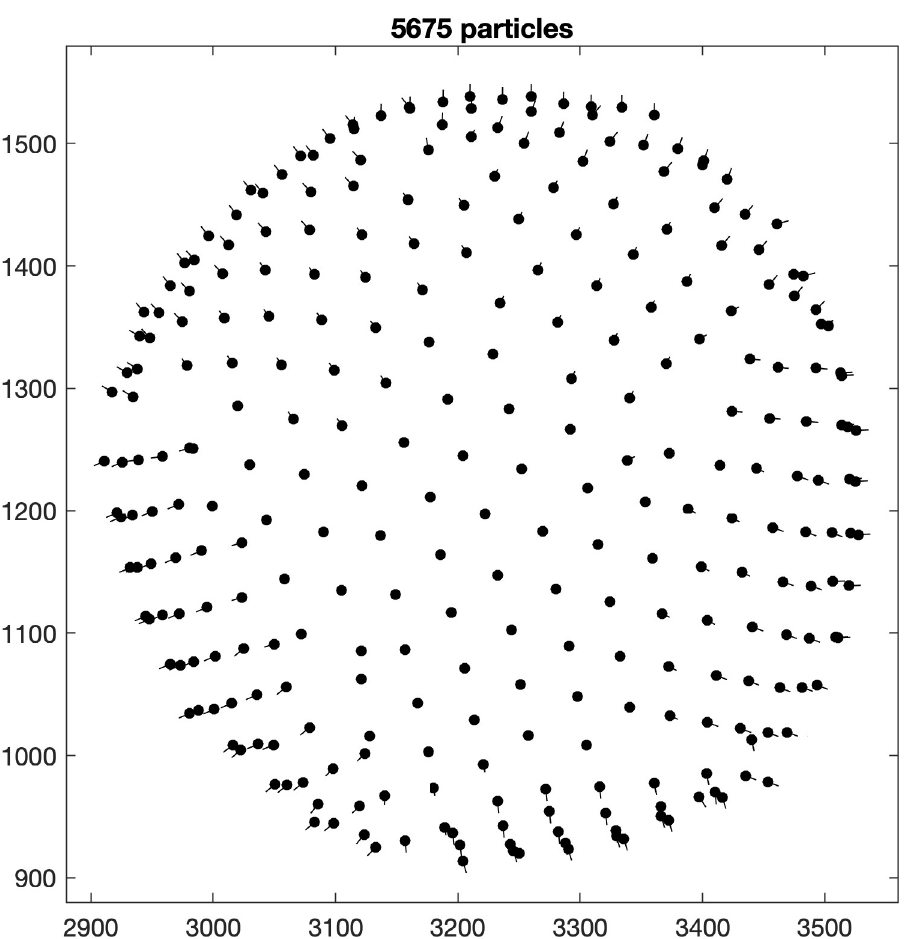
Fig 6. Resulting coordinates from particle picking. Particle coordinates on the surface of one VLP from tomogram ts001 are shown using the Dynamo command dtplot to demonstrate the results from the particle picking. The hexagonal lattice structure inherent to the immature HIV-1 CA-SP1 is clearly visible. A slight deviation from a perfect sphere is also notable. The data and commands to exactly reproduce this figure are available on EMPIAR (EMPIAR- 10702). EMPIAR, Electron Microscopy Public Image